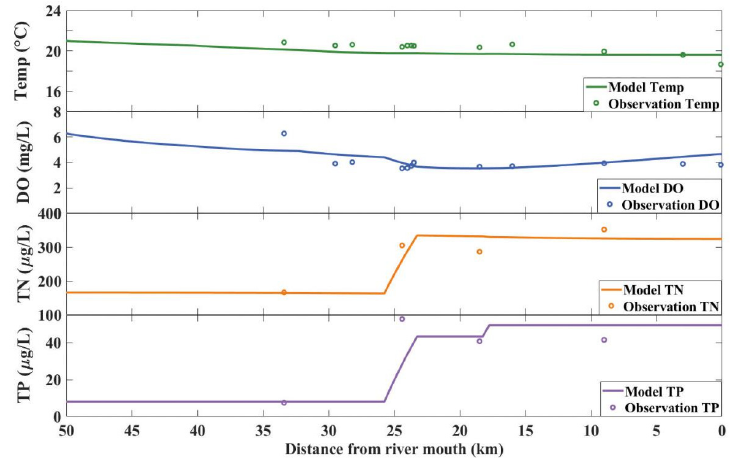
Figure 3. Model annual average water temperature and DO/TN/TP concentrations along the Shoalhaven River in 2017 compared with observations (model calibration).